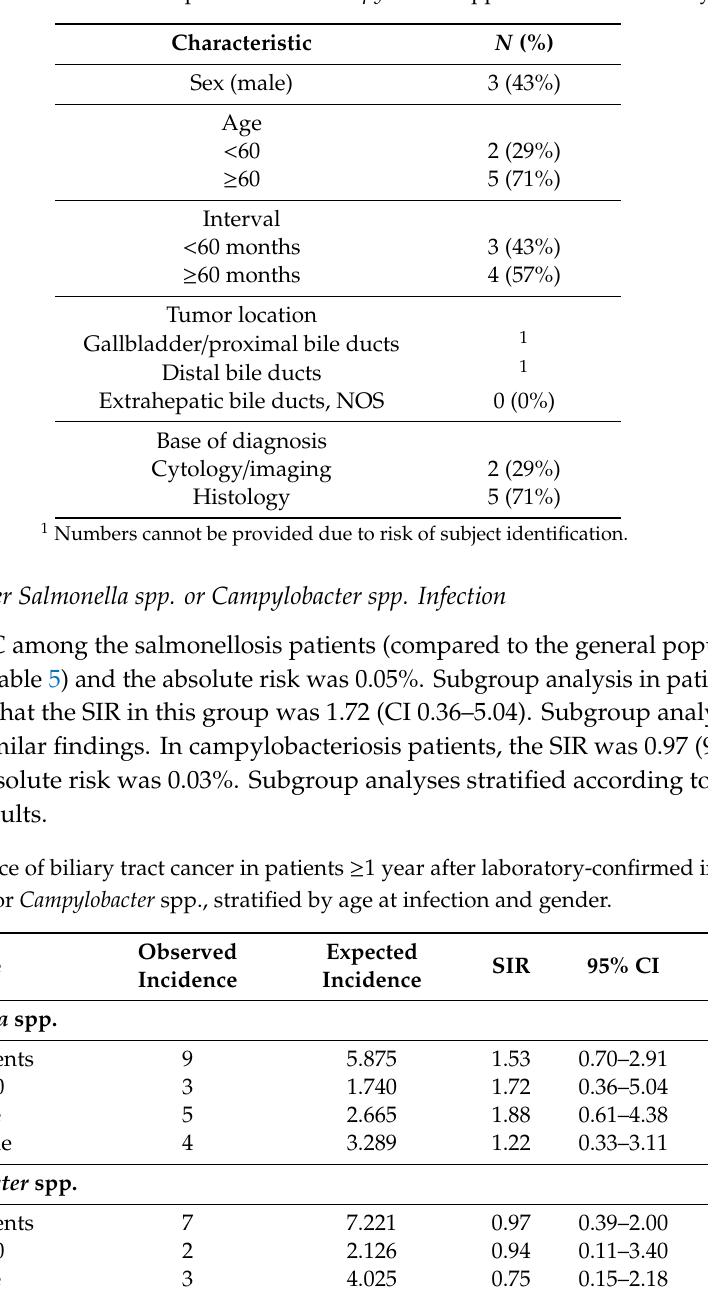
Table 4. Baseline characteristics of patients with Campylobacter spp. infection and biliary tract cancer.